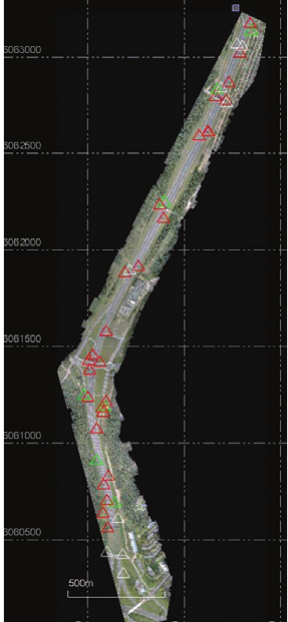
Fig. 5. Distribution of GCPs (marked by white triangles – signalized points, green – check points, red – control points) on the test area